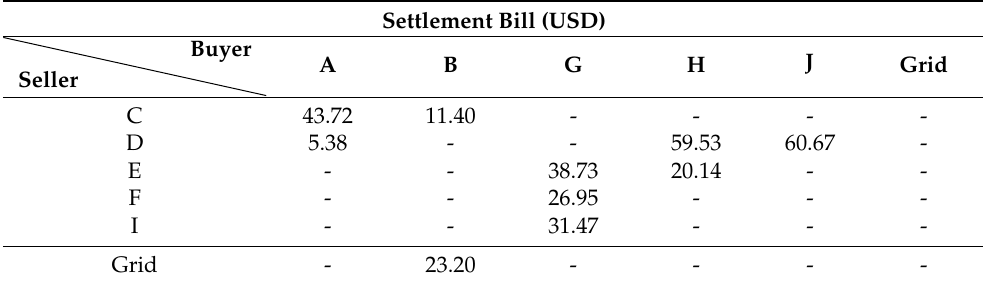
Table 7. The settlement